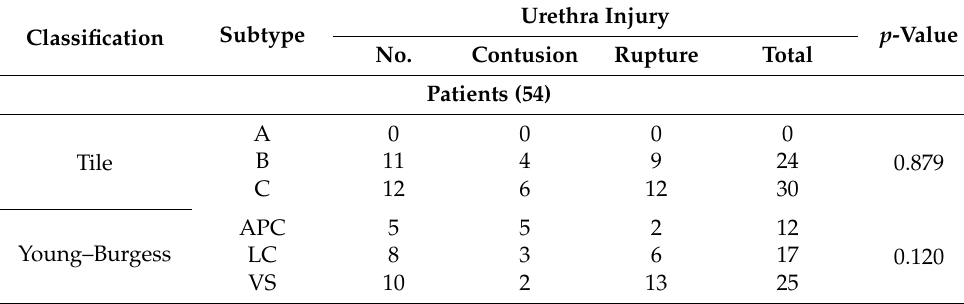
Table 4. Fracture pattern and injury to the urethra ( n = 54).